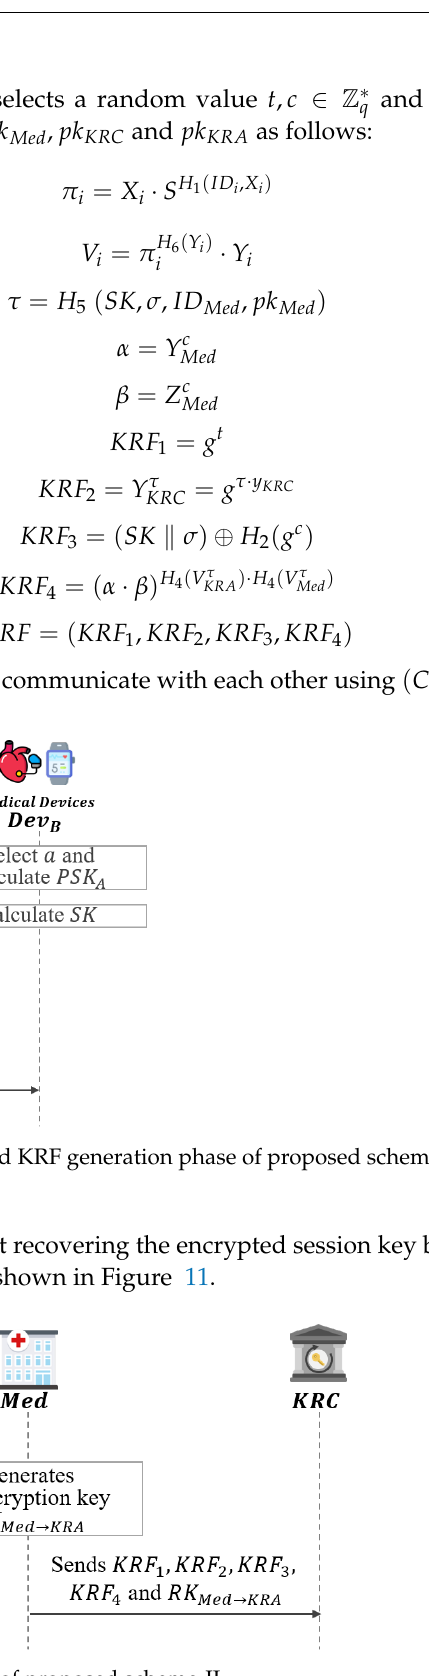
Figure 11. Med enforcement phase of proposed